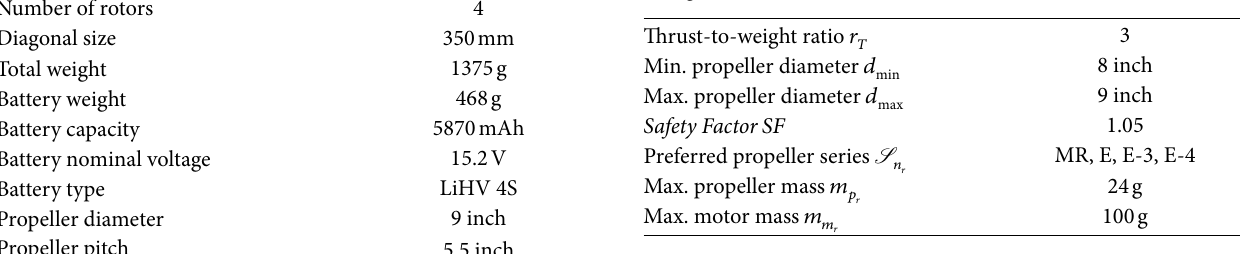
Table 4: Basic DJI Phantom 4 V2.0 parameters. Table 5: Additional methodology parameters used in small drone